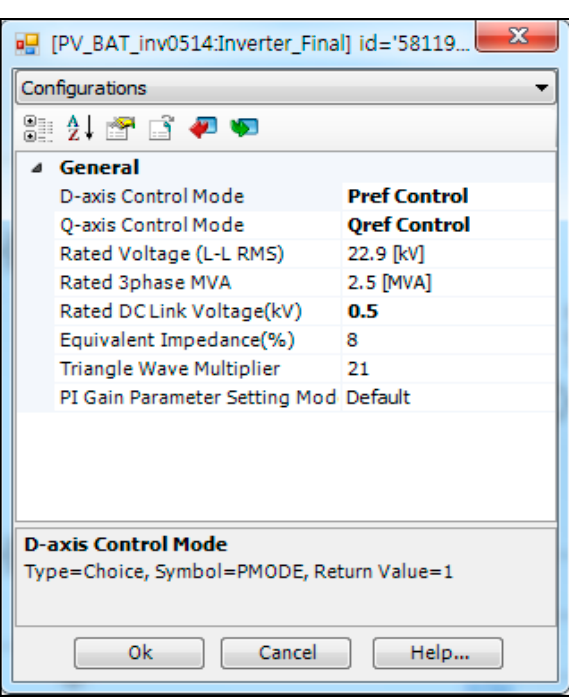
Figure 33. Inverter control modeling for Fortran language.